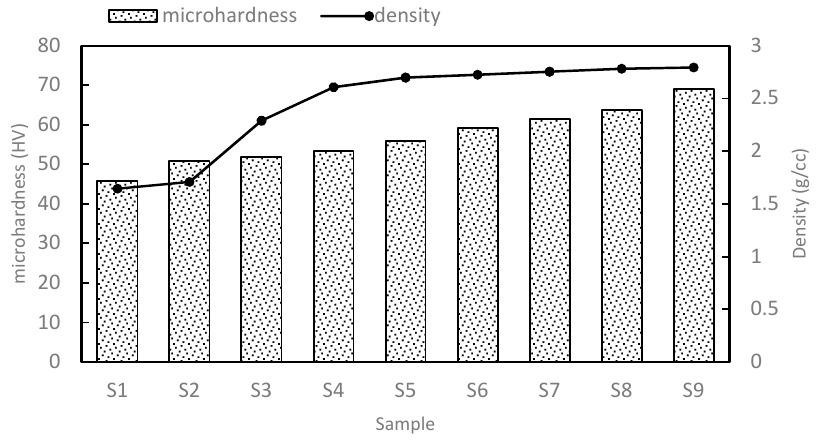
Figure 8. Microhardness and density graph at different temperatures and holding times.